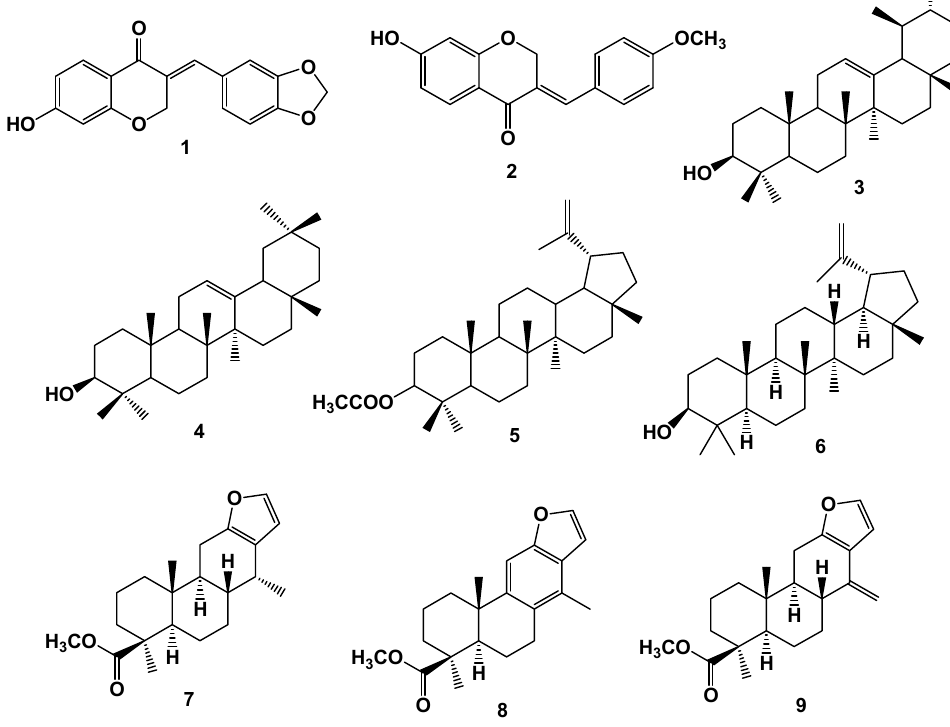
Figure 1. Phenolic compounds and triterpenoids isolated from species of Caesalpinia with antibacterial